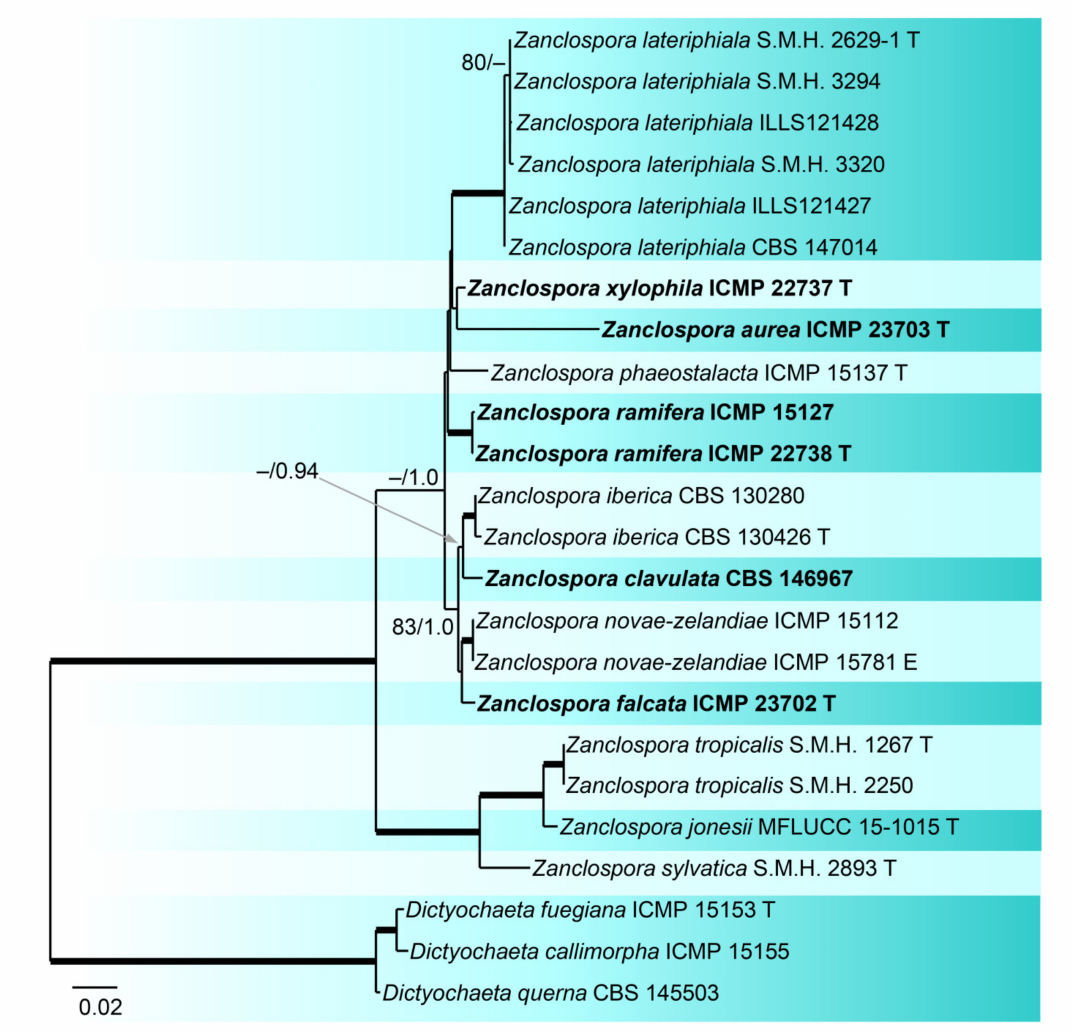
Figure 3. Combined phylogeny of ITS, 28S, tef1- α and tub2 sequences of Zanclospora . Names given in bold are new species. T and E indicate ex-type and ex-epitype strains. Thickened branches indicate branch support with ML BS = 100%, PP values = 1.0. Branch support of nodes ≥ 75% ML BS and ≥ 0.95 PP is indicated above or below